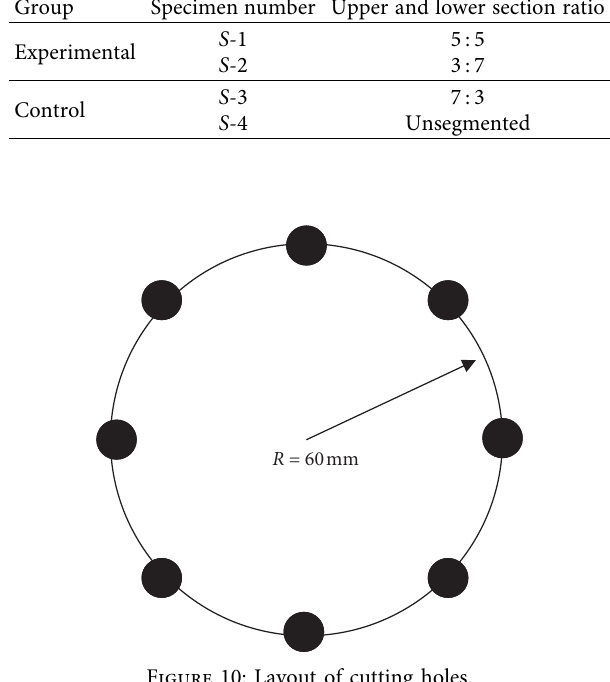
Figure 10: Layout of cutting holes.